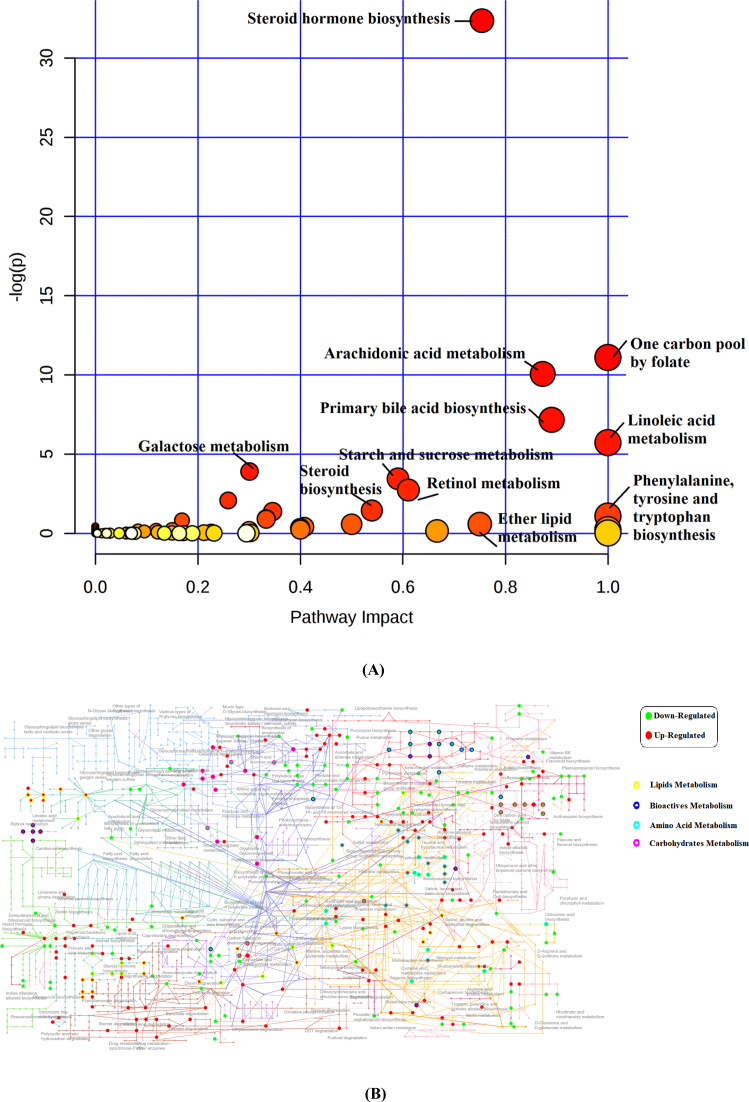
The pathway enrichment and network analyses for the significant metabolites in female C. idellus. (A) The scatter plot was used to visualize the pathway impact and enrichment results for all matching significant metabolites in female C. idellus. (B) The KEGG global metabolic network visualization of all significant metabolites (P < 0.05) in the female C. idellus metabolic profile. The colored points represent different metabolic pathways. The various color levels indicate different levels of significance of metabolic pathways from low (white) to high (red). The different sizes of each point are used to represent the number of metabolites that participated in the metabolic pathway. The greater the rich factor, the greater the degree of pathway enrichment. Moreover, the corresponding pathway's name of each point is labeled. In the metabolic network, all upregulated metabolites (FC AF/GF >2) in AF groups are colored red, whereas the downregulated metabolites (FC <0.5) are colored green. In addition, the different color circles represent the various physiological functions that the discriminating metabolites belong to. Moreover, each enriched pathway is annotated with the corresponding name.